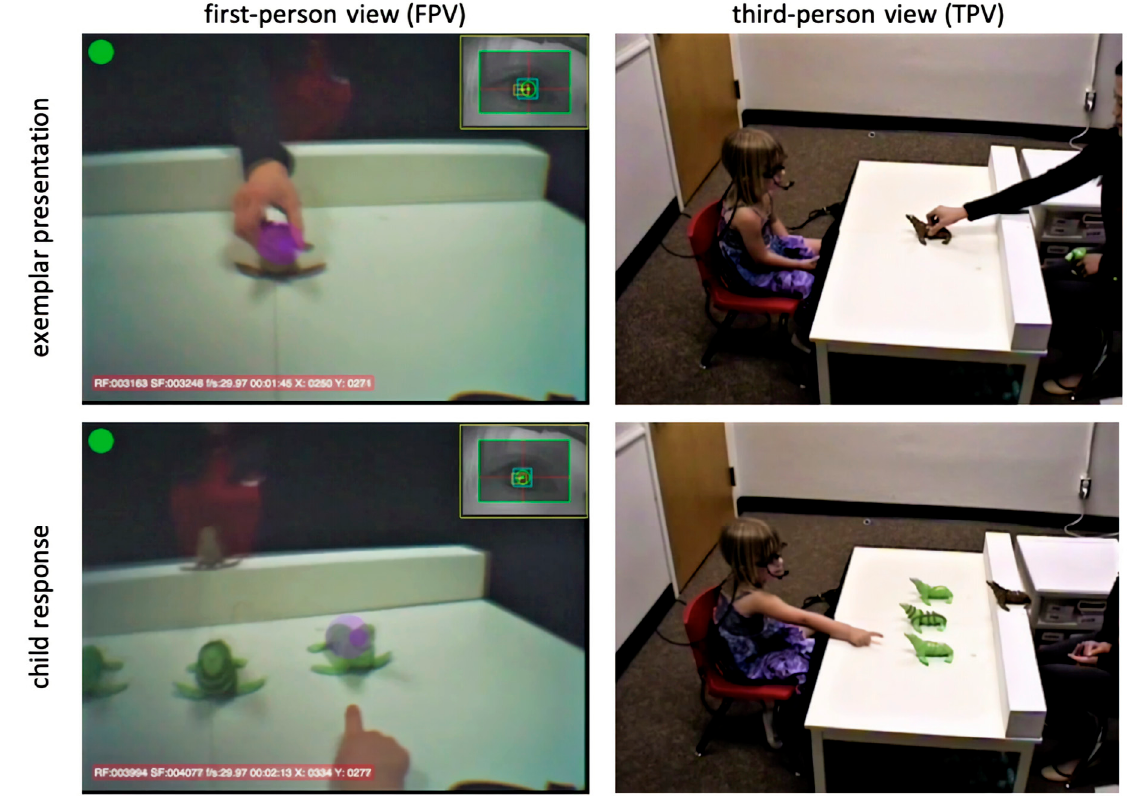
Figure 2. First-person view (FPV) was recorded by having the child wear a head-mounted eye tracking headset. A room view (third person view: TPV) was recorded by a wall-mounted camera in the testing room. Videos from these cameras were joined and synchronized with child eye tracking coordinates superimposed over the FPV image (pink/purple circles indicating the point of focus).